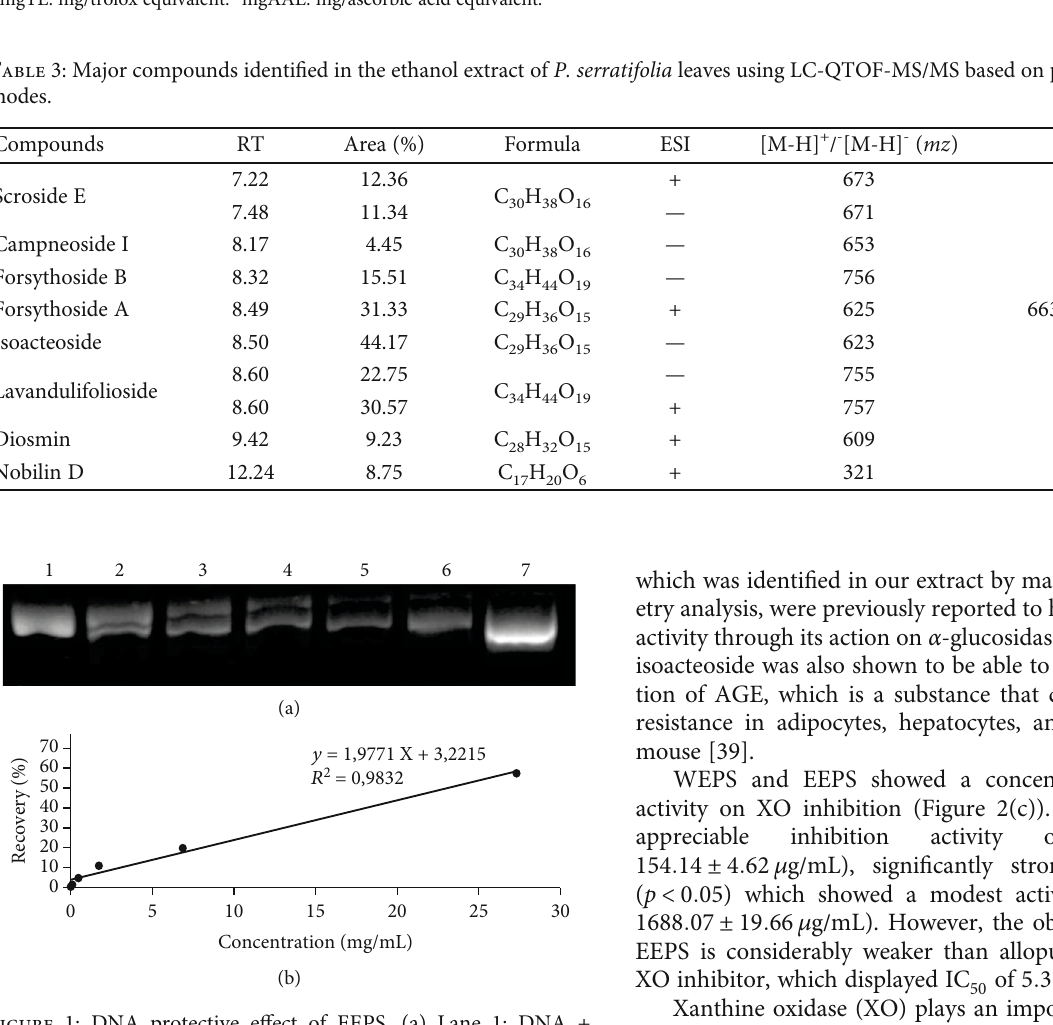
O /Fe 2+ treated with EEPS (0.11, 2 2